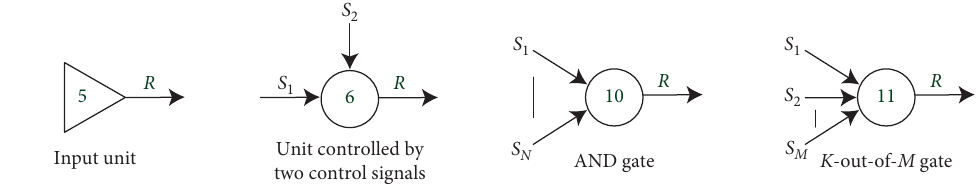
Figure 4: The operators of the